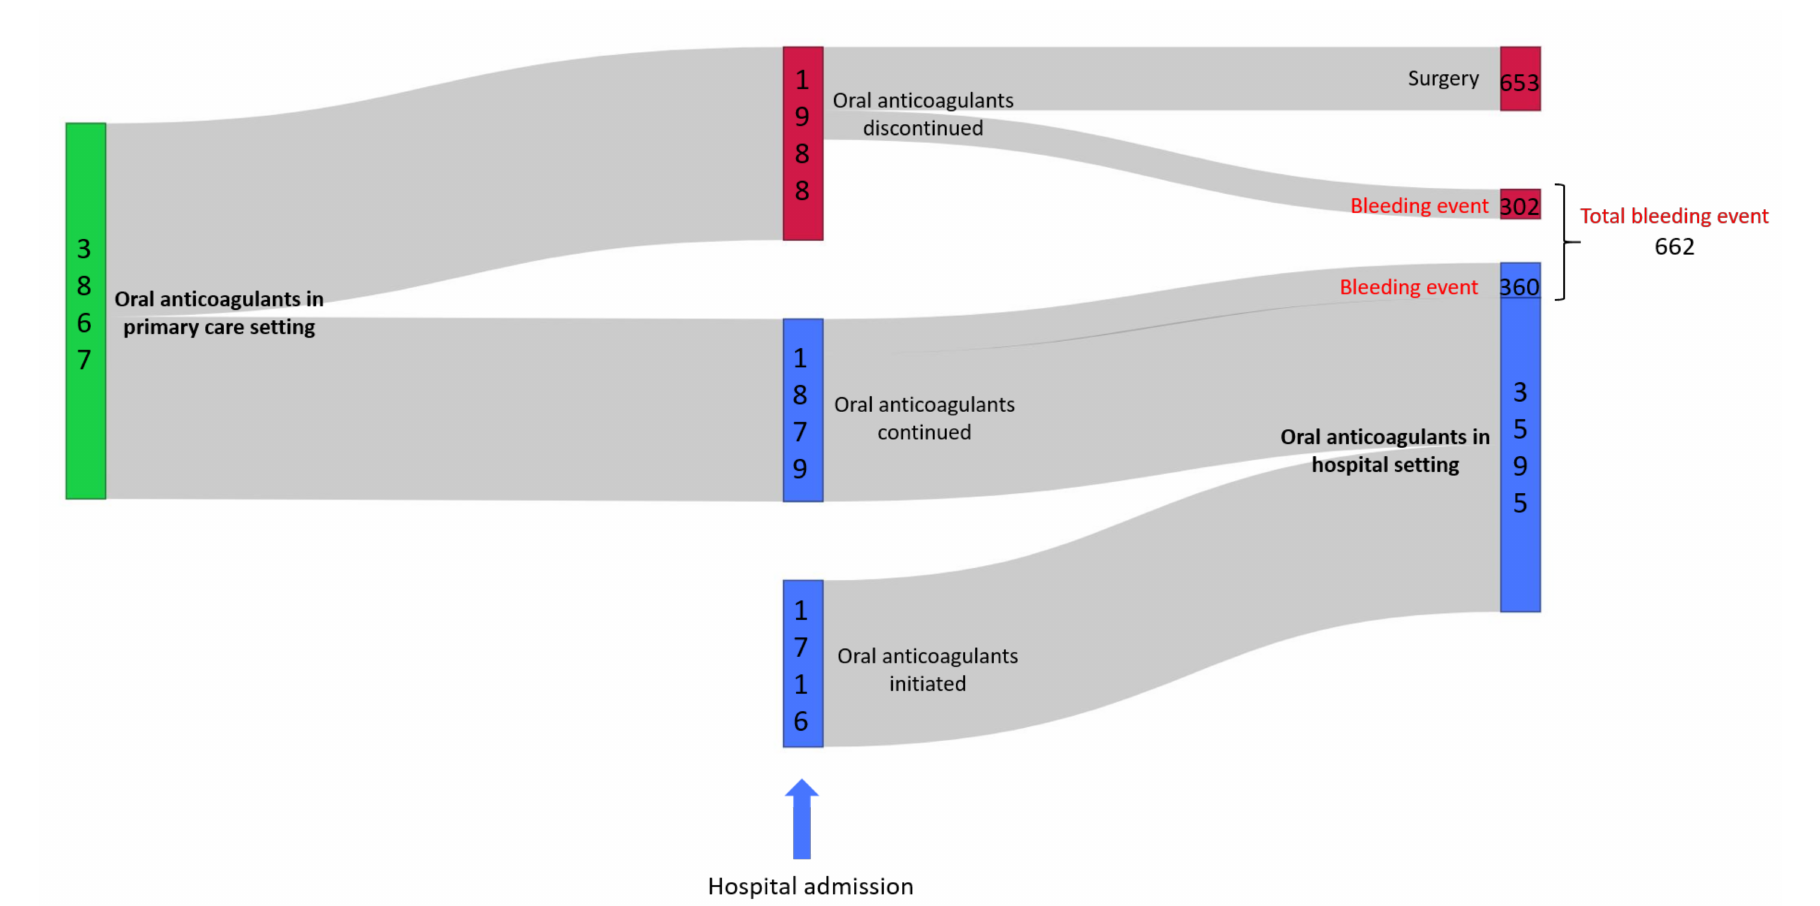
Figure 1. Sankey diagram representing the oral anticoagulant pathway of the 5583 hospitalized patients treated by oral anticoagulants in primary care and/or during their